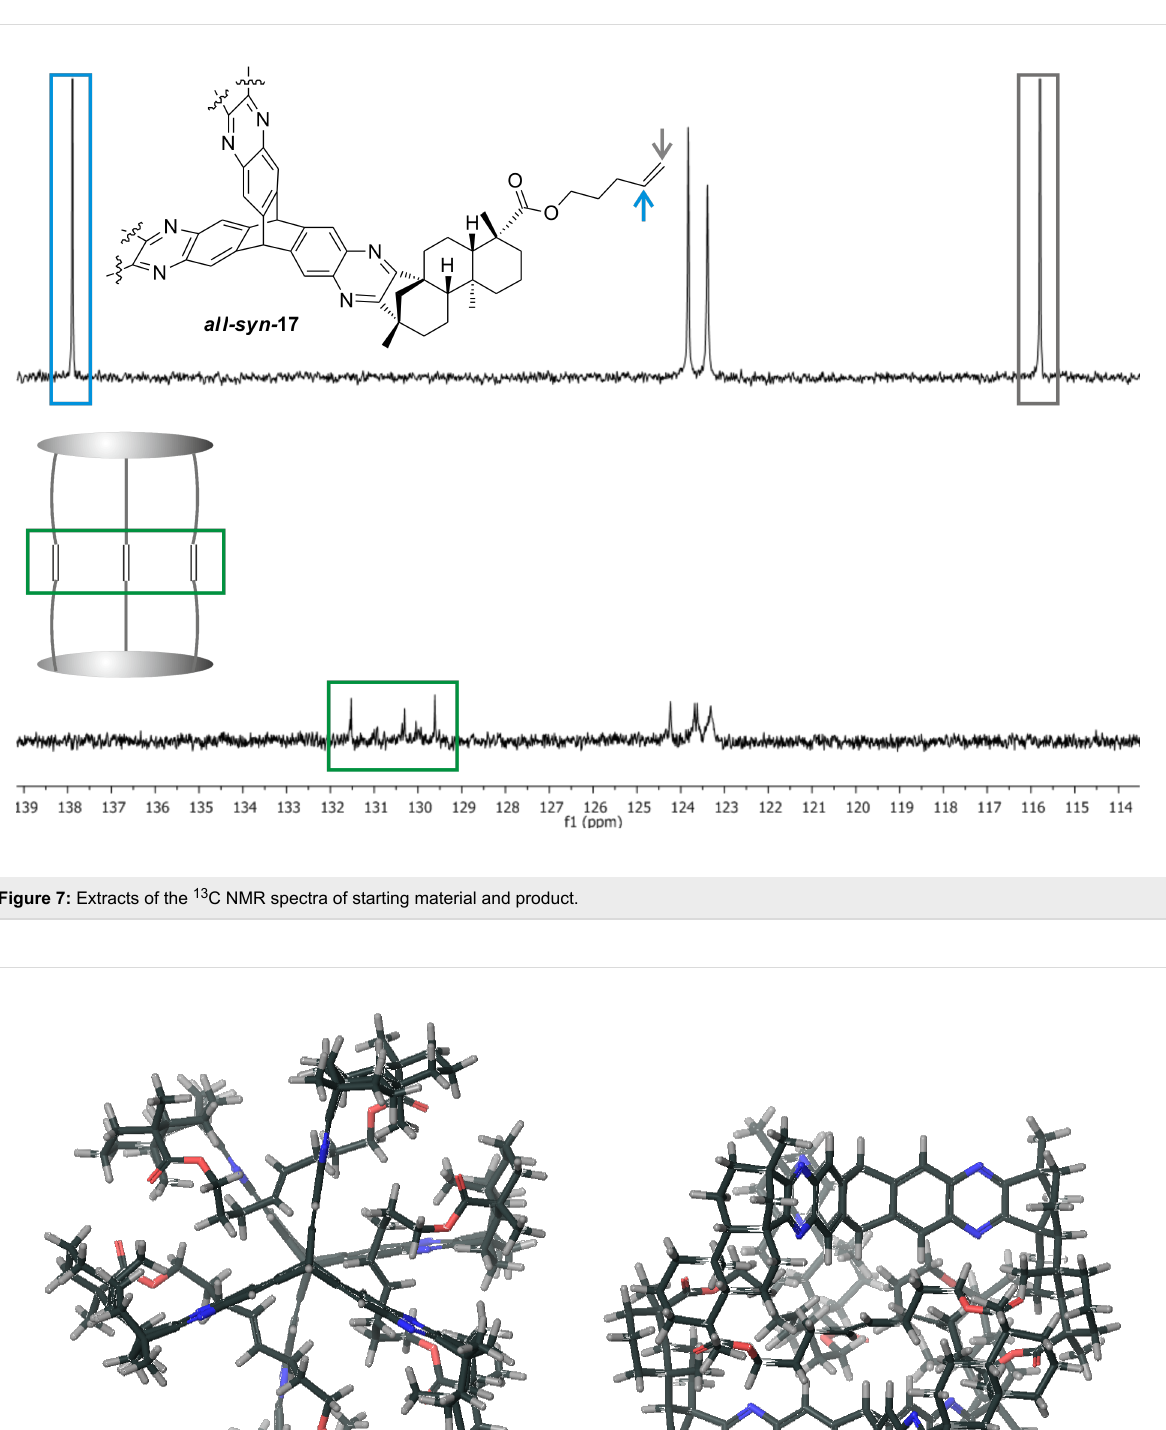
Figure 8: Molecular modelling structure (MacroModel 9.3.5) of collapsed 19 , (a) top view; (b) side